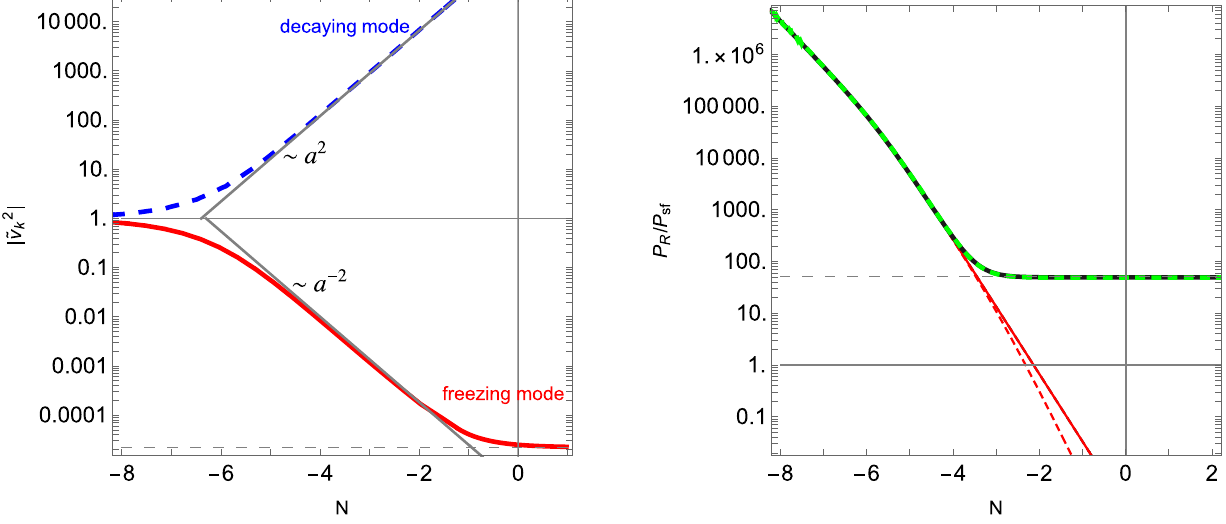
that the sound speed decreases as ∼ a − 2 . Right panel: evolution of the instantaneous power spectra in the full theory and in the effective theory; color coding described in Table 1; thin dashed line corresponds to the asymptotic value (37). N = 0 corresponds to the Hubble radius